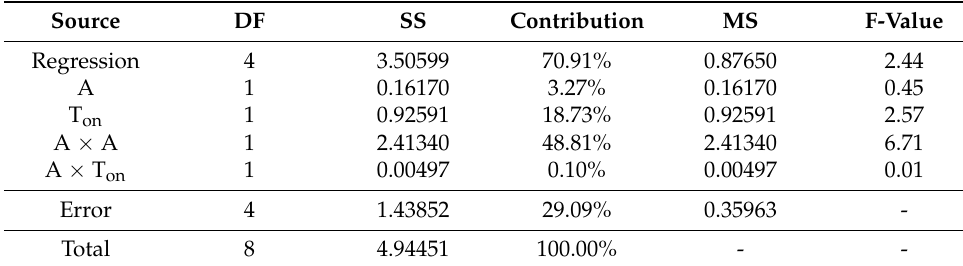
Table 12. Analysis of Variance: Surface roughness—Al6351–5%SiC–10%B 4